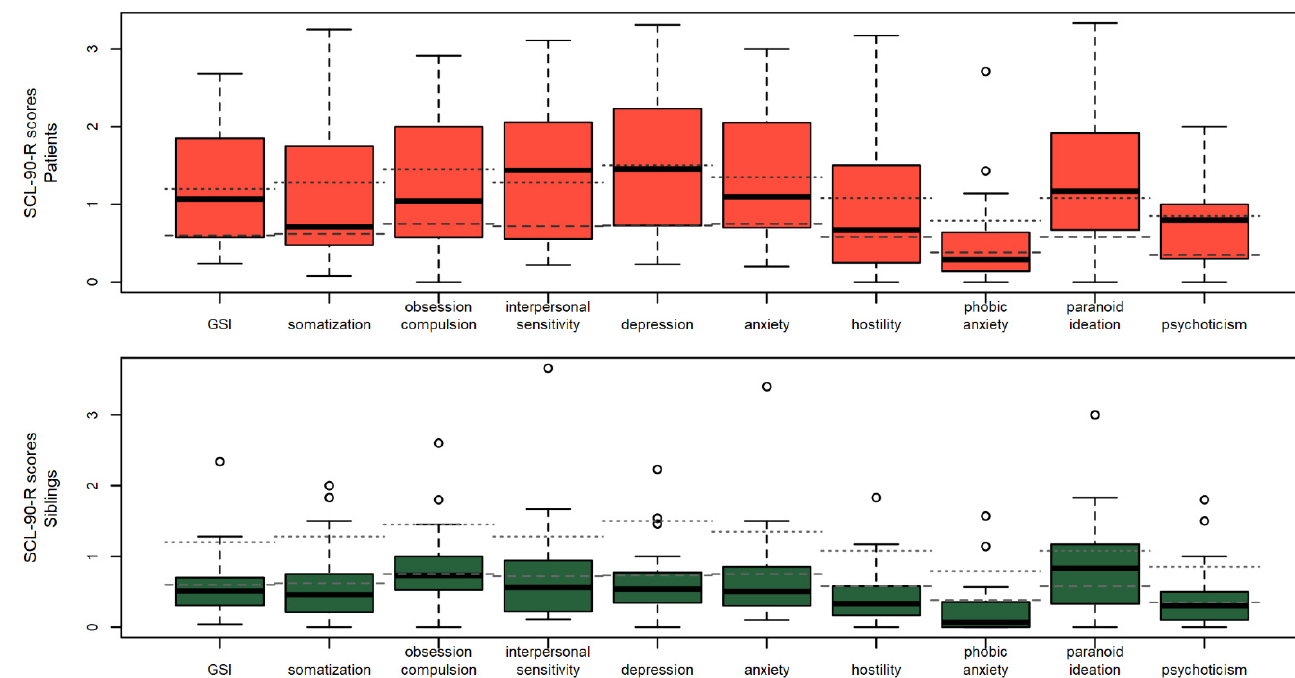
Figure 3. SCL-90-R scores in patients and siblings. The dashed and dotted segments define the cut-offs for moderate and severe symptoms, respectively [45], ◦ = outliers.